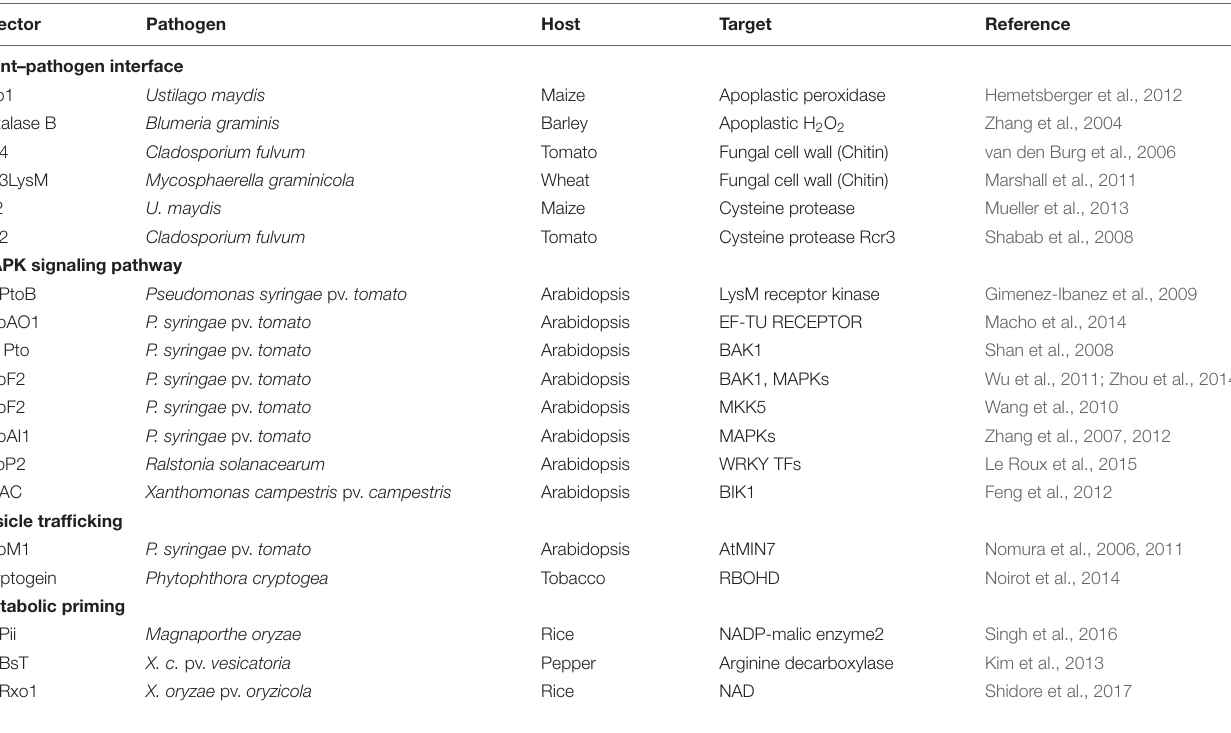
TABLE 1 | Effector targets associated with ROS signaling in